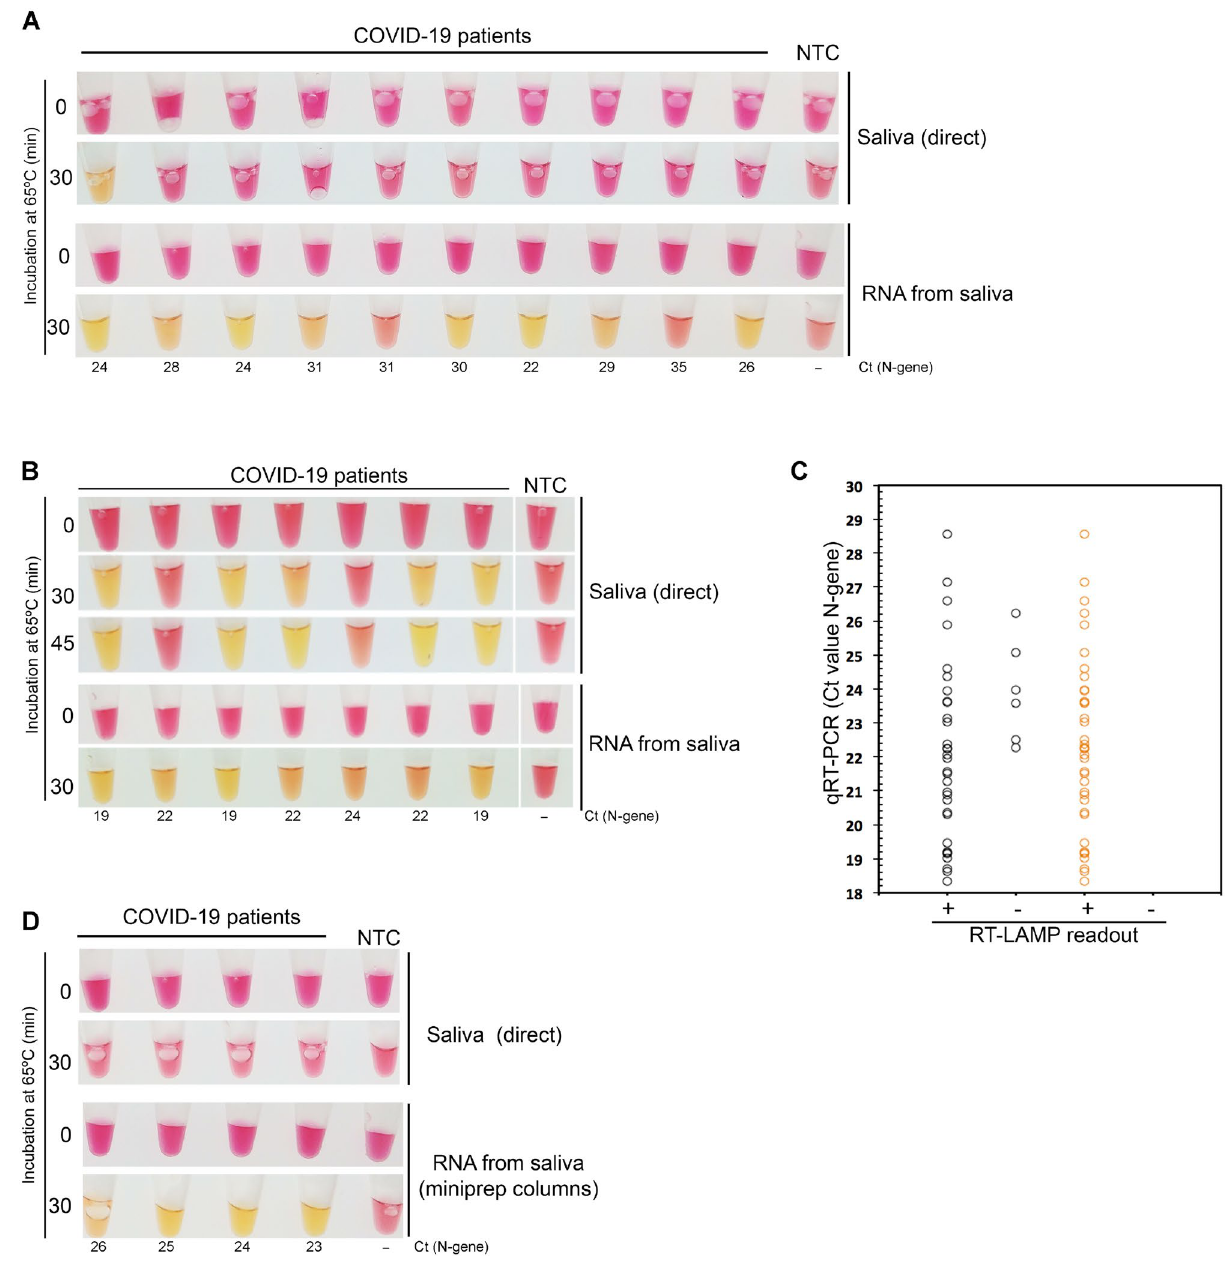
Figure 4. Detection of SARS-CoV-2 in saliva samples using RT-LAMP. RT-LAMP analysis of saliva samples of confirmed COVID-19 patients who ( A ) induced or not ( B ) salivation before sample collection. ( C ) Comparison of RT-LAMP and RT-PCR results. The Ct values (RT-PCR results) of 39 COVID-19 positive patients (y-axis) were compared to the RT-LAMP readout of the matched saliva samples (x-axis), after 30 min of incubation at 65 °C (positive, +/yellow; negative, −/pink). Black circles—direct saliva; orange circles—RNA extracted from saliva. ( D ) RNAs from the saliva of false negative samples (as determined by the direct saliva test) were extracted using plasmid DNA miniprep columns (ZR Plasmid Miniprep-Classic Kit, Zymo Research) and re-analyzed. NTC no template control. Cts (N gene) obtained for the paired NP samples are